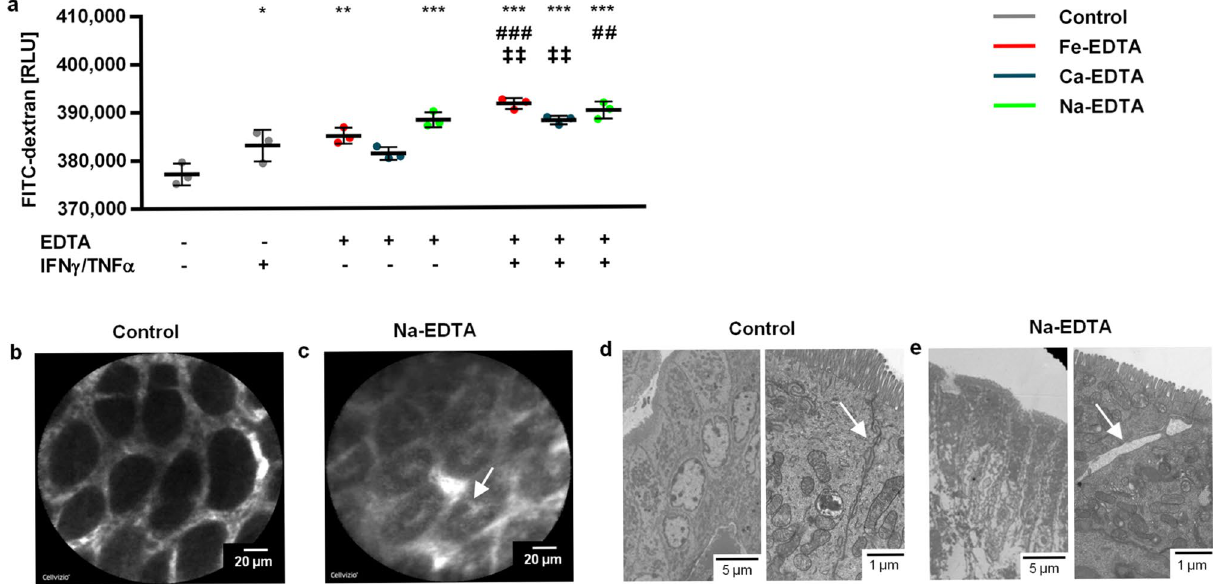
Figure 3. EDTA compounds increase paracellular permeability by damaging intercellular contacts. ( a) Results of the in vitro FITC-dextran permeability assay on T84 cell monolayers exposed to EDTA compounds and/ or IFNγ plus TNFα as noted. Error bars represent standard deviations. Asterisks (*: p < 0.05; **: p < 0.01; ***: p < 0.001) denote statistically significant results compared to the control group, hashtags ( # : p < 0.05; ## : p < 0.01; ### : p < 0.001) mark significant differences compared to the IFNγ plus TNFα treated monolayers, and double daggers ( ‡ : p < 0.05; ‡‡ : p < 0.01; ‡‡‡ : p < 0.001) indicate significant comparisons between EDTA compounds with or without IFNγ plus TNFα. ( b , c ) Confocal laser endomicroscopy of intestinal epithelium in healthy mice pretreated with Na-EDTA rectally ( c ) or sham treated (controls; b ). The arrow shows accumulation